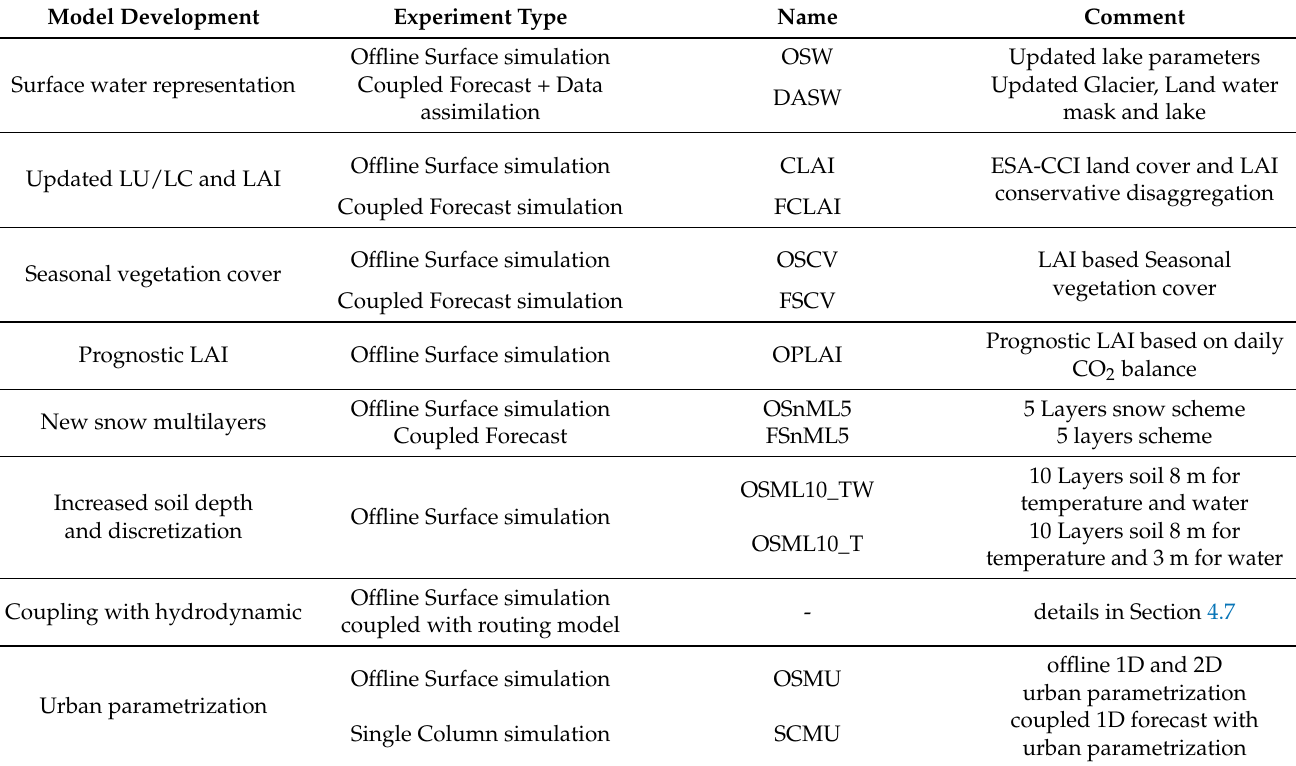
Table 1. Experimental configurations for the evaluation of model